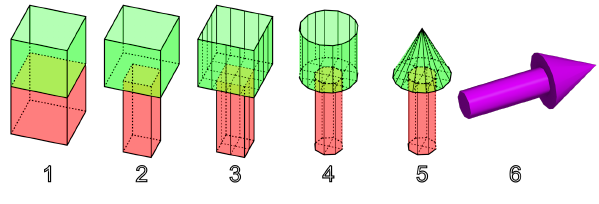
Figure 7: Glyph generation